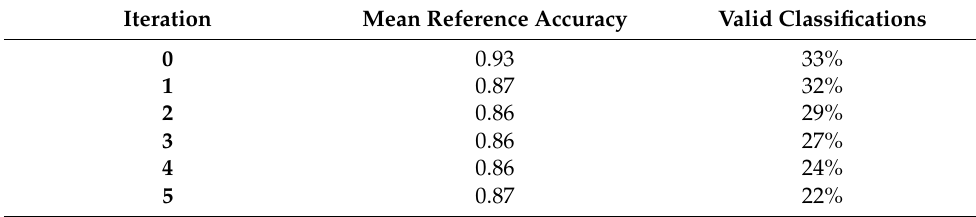
Figure 11. Training results for driver 4 (non-causal). Table 6. Mean reference accuracy and share of valid classifications for the non-causal Driver 4. Iteration Mean Reference Accuracy Valid